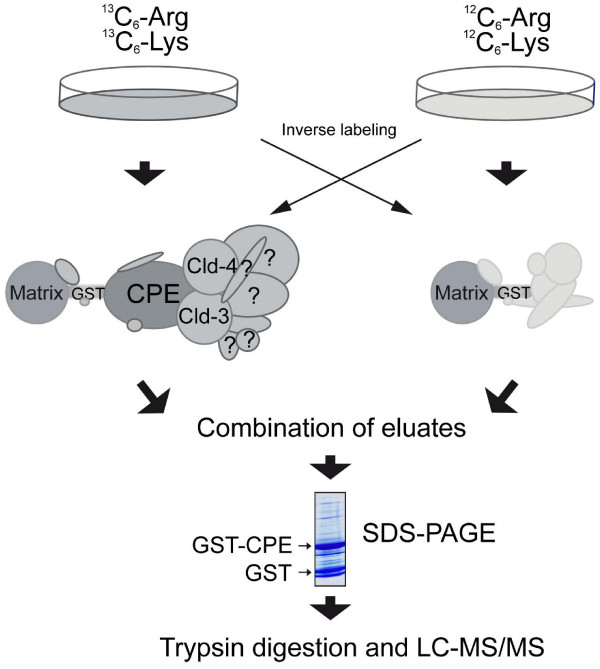
Strategy for affinity purification using GST- CPE116–319 as "bait". For affinity purification, one cell population is grown in medium containing [12C]arginine and [12C]lysine, whereas the other is grown in medium supplemented with [13C]arginine and [13C]lysine. Bound proteins of both pull-down fractions are combined and separated by SDS-PAGE. After tryptic in-gel digestion, proteins are identified by LC-MS/MS, and the ratios of their abundance are quantified from MS peak intensities.